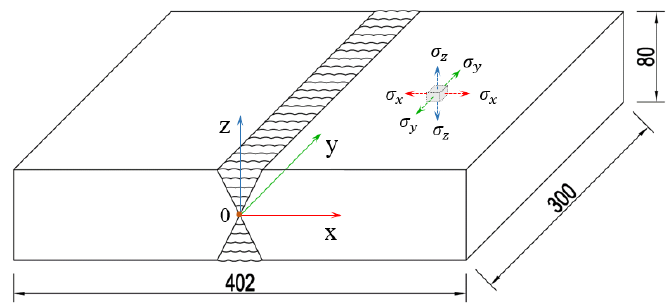
Figure 7. Definition of residual stress direction.